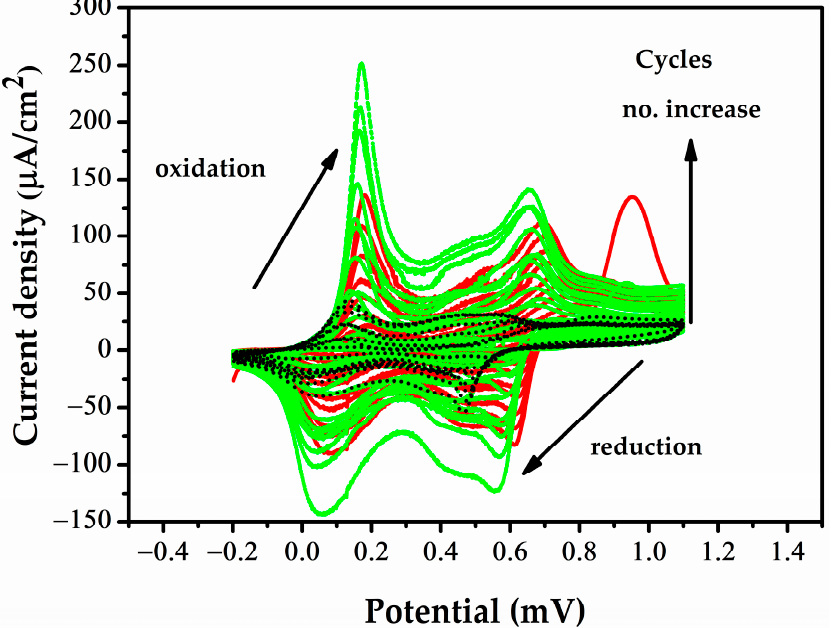
Figure 2. Cyclic voltammograms of 8 (black), 10 (red), and 15 (green) electropolymerization cycles of the MWCNT-NH 2 -PANI composite material .